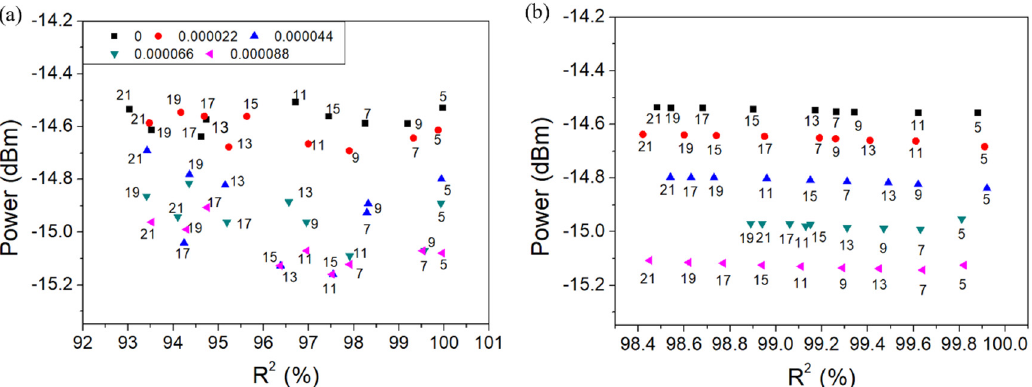
Figure 9. Amplitude of the cladding mode No. 10 after Gauss fitting in terms of SRI change 8.8 ×10 − 5 for wavelength resolution 0.07 nm (unweighted ( a ) and weighted ( b )).